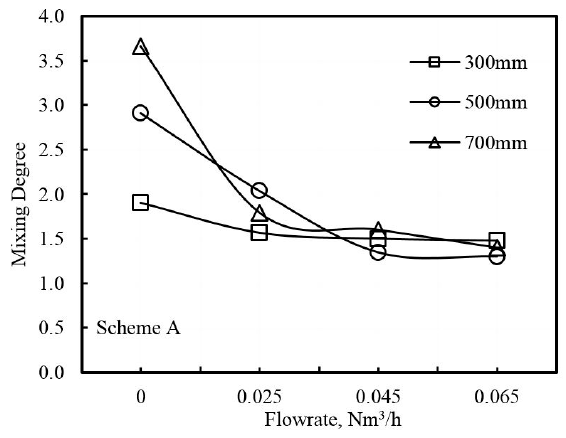
Figure 13. Mixing degree as a function of bottom blowing flowrate using Scheme A.